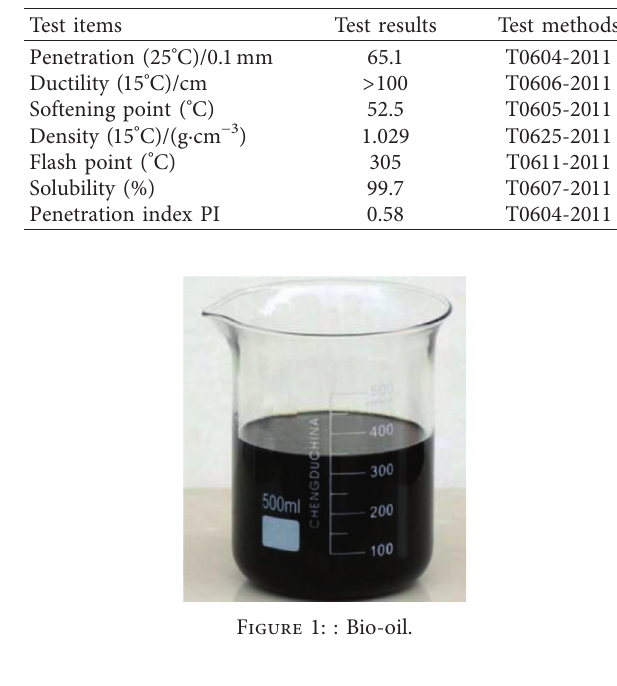
Table 1: Performance indexes of matrix asphalt.